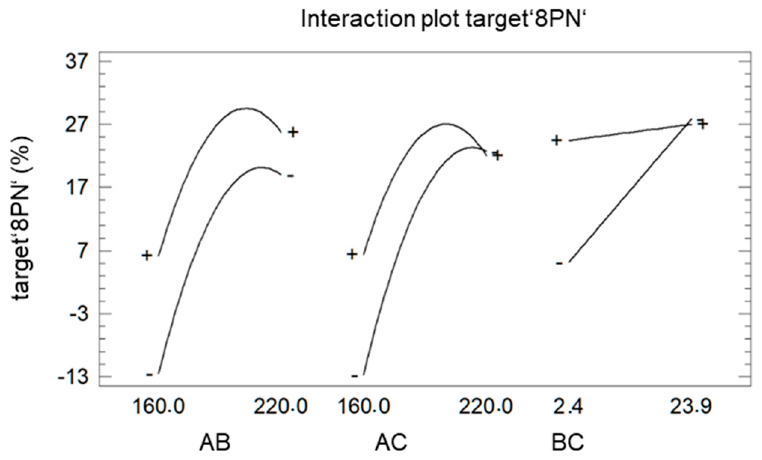
Figure 6. Interaction plot of target ‘8PN’ A: factor ‘temperature’ B: factor ‘LiCl’ C: factor ‘time’.